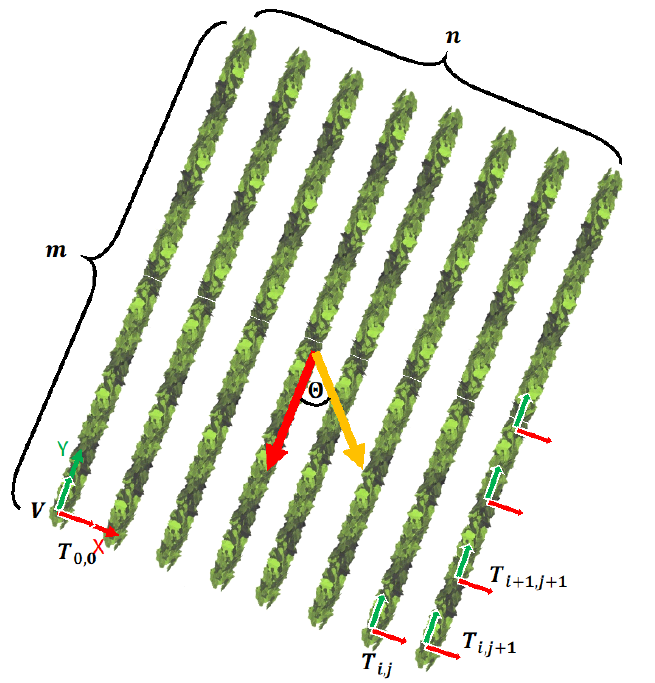
Figure 7. The example of a vineyard layout with a uniform length of the vine rows, meaning that each row contains the same number of planted vines.